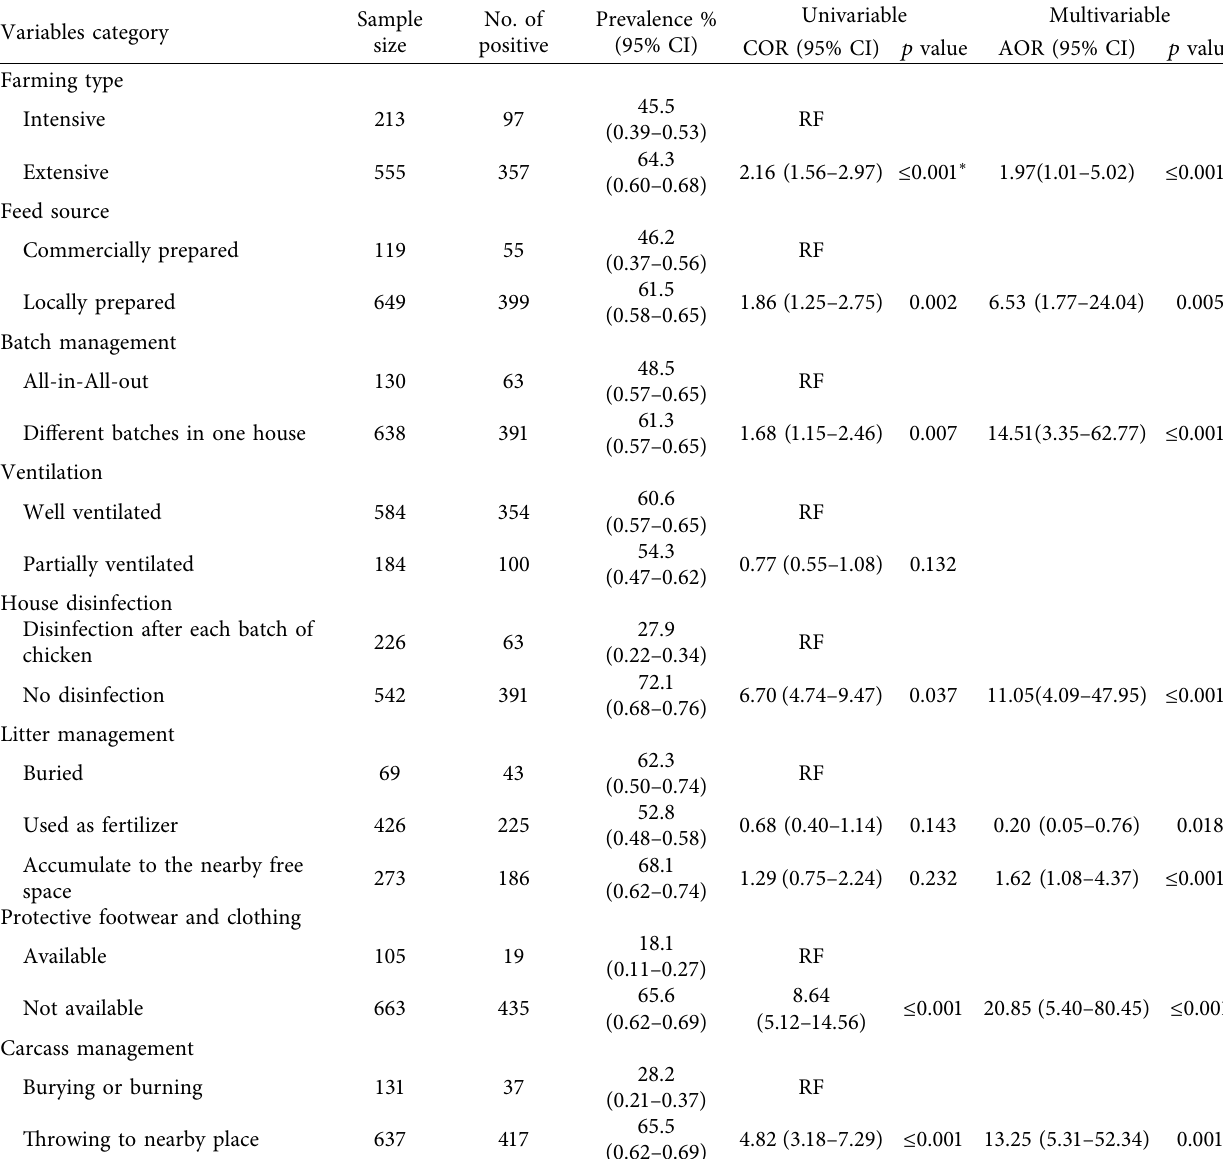
Table 5: Univariable and multivariable mixed-effect logistic regression analysis of environmental risk factors with ILTV seroprevalence. Variables